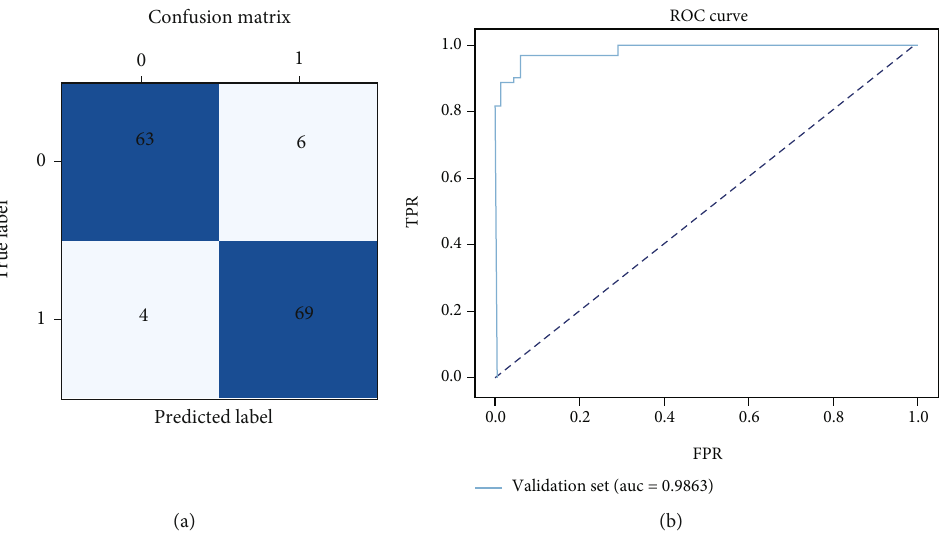
Figure 8: Classi fi cation results on the validation set. (a) Confusion matrix and (b) ROC